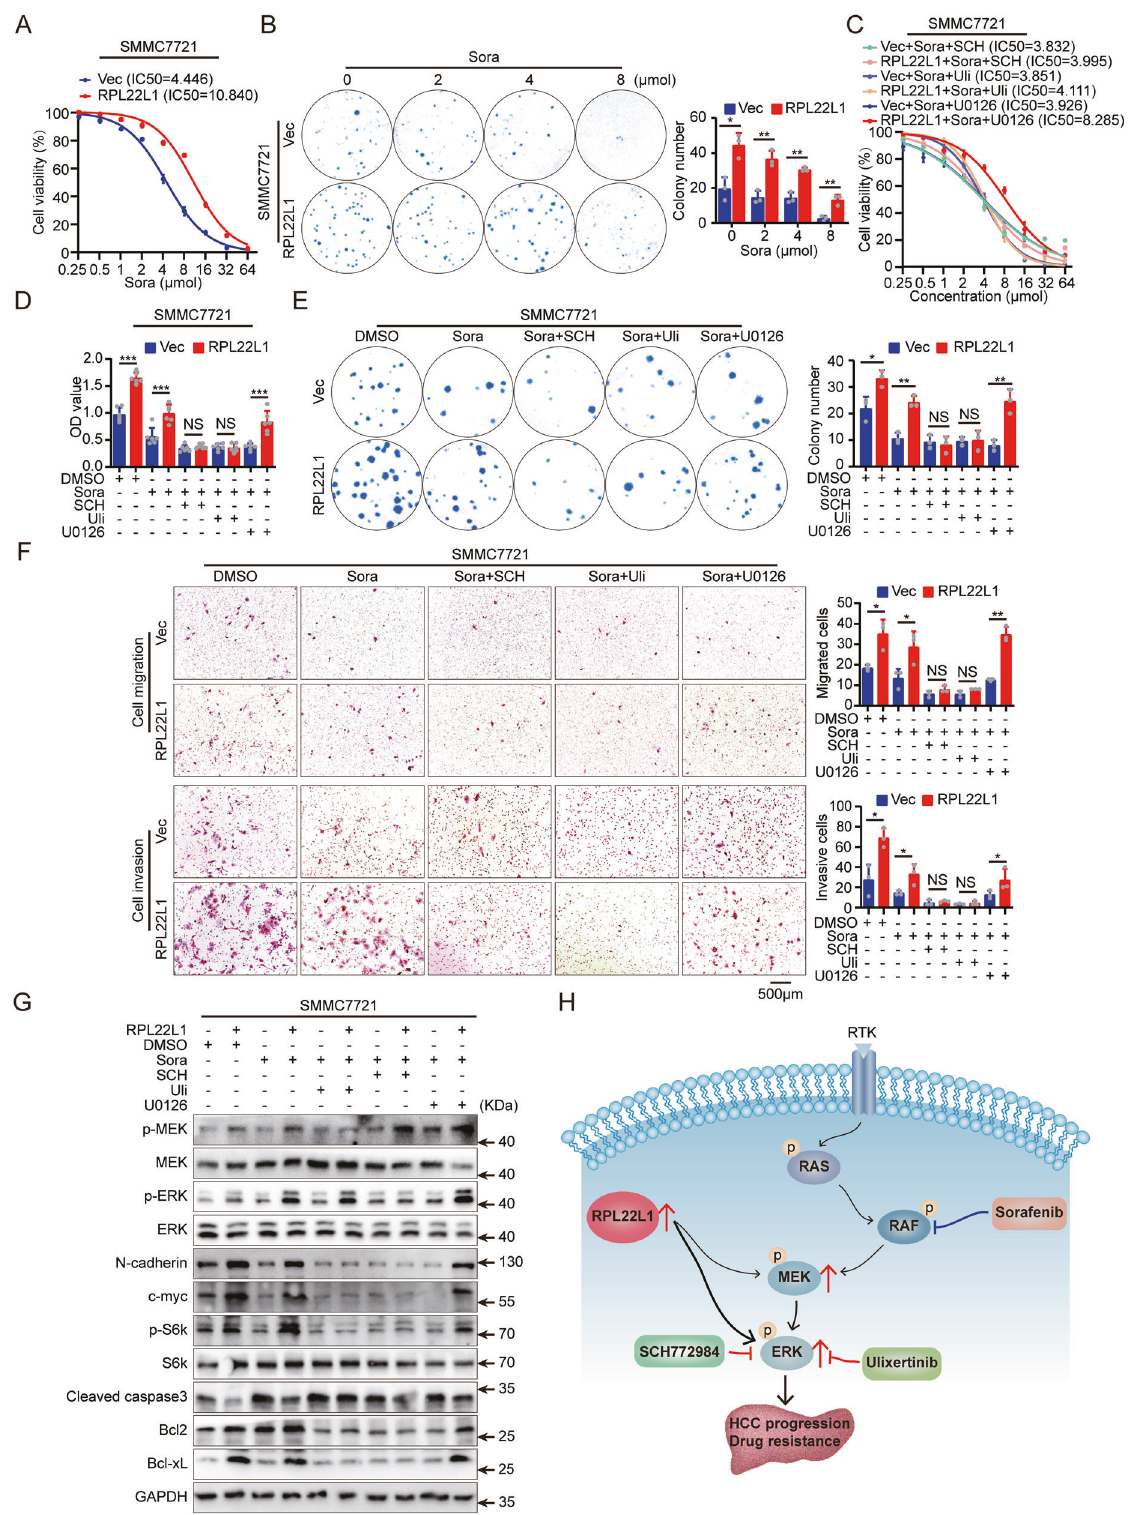
Fig. 4 ERKi synergizes with sorafenib in RPL22L1-high cells. A MTS assay showed dose-dependent effect of sorafenib on cell viability. IC50 values were calculated. B Colony formation of cells treated with different concentrations of sorafenib. Colony numbers were counted. C IC50 values of sorafenib combined different ERKi were determined by MTS assays. D MTS and E colony formation assays showed cell proliferative ability under treatment with sorafenib alone or combination with different ERKi at 8 μ mol concentration. F Transwell assays showed cell migration and invasion capability after treatment with sorafenib alone or combination with different ERKi. Scale bars = 500 μ m. Data are shown as mean ± SD of three independent experiments. Student ’ s t-test. NS non-signi fi cant, * P < 0.05, ** P < 0.01, *** P < 0.001. G Western blots showed the effect of sorafenib alone or combination with different ERKi on cells. H Illustration depicted RPL22L1 modulating sorafenib sensitivity via activation of ERK, and the enhancement of sorafenib ef fi cacy by combining with ERKi. Cell Death Discovery (2022)